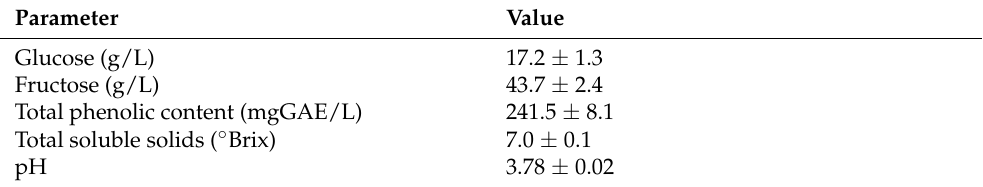
Table 1. Composition of clarified apple juice subjected to a diafiltration − nanofiltration process.